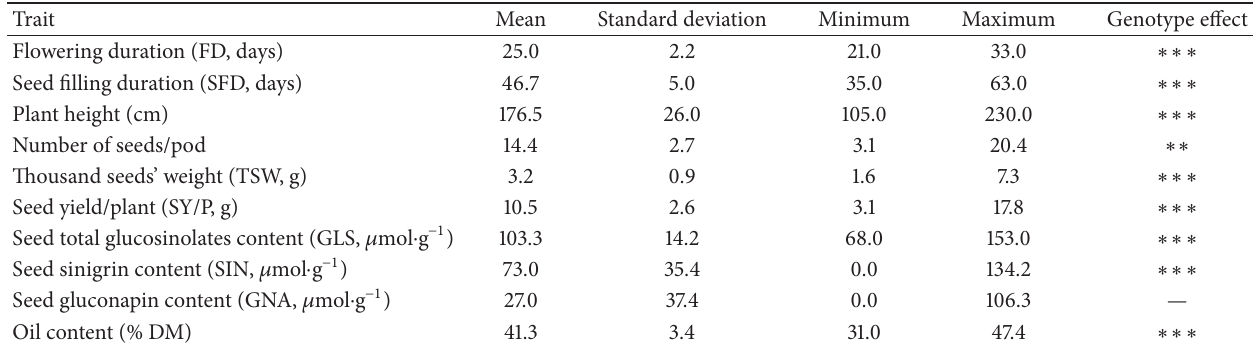
Table 2: Mean, standard deviation, and minimal and maximal values of seed glucosinolates compositions as well as agronomical traits measured on a collection of 190 genotypes. Genotypic effect for each trait is also displayed.